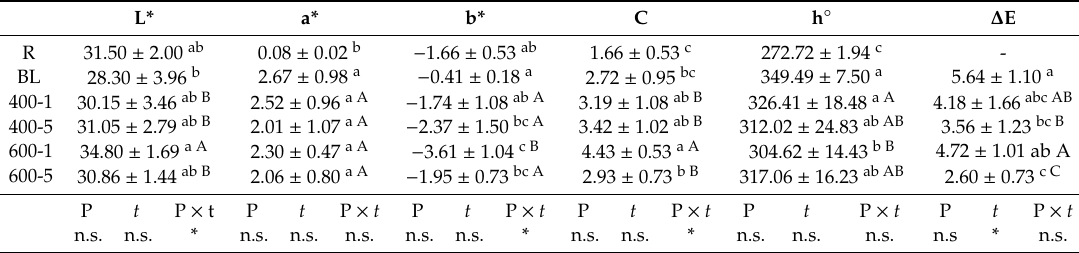
Table 3. Color parameters for raw and treated blueberries †